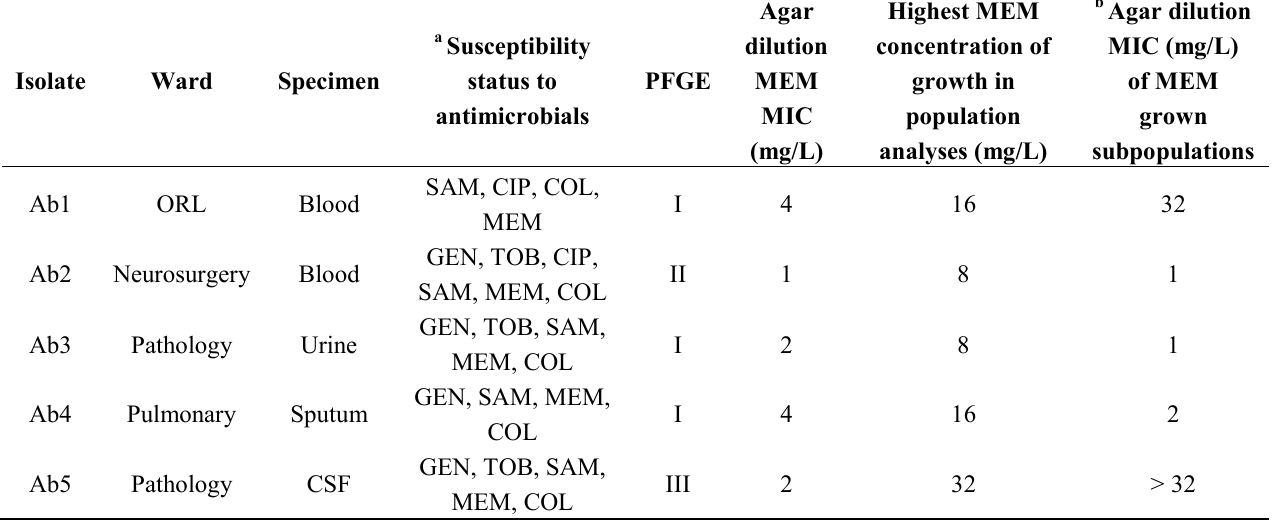
Table 1. Characteristics of the study